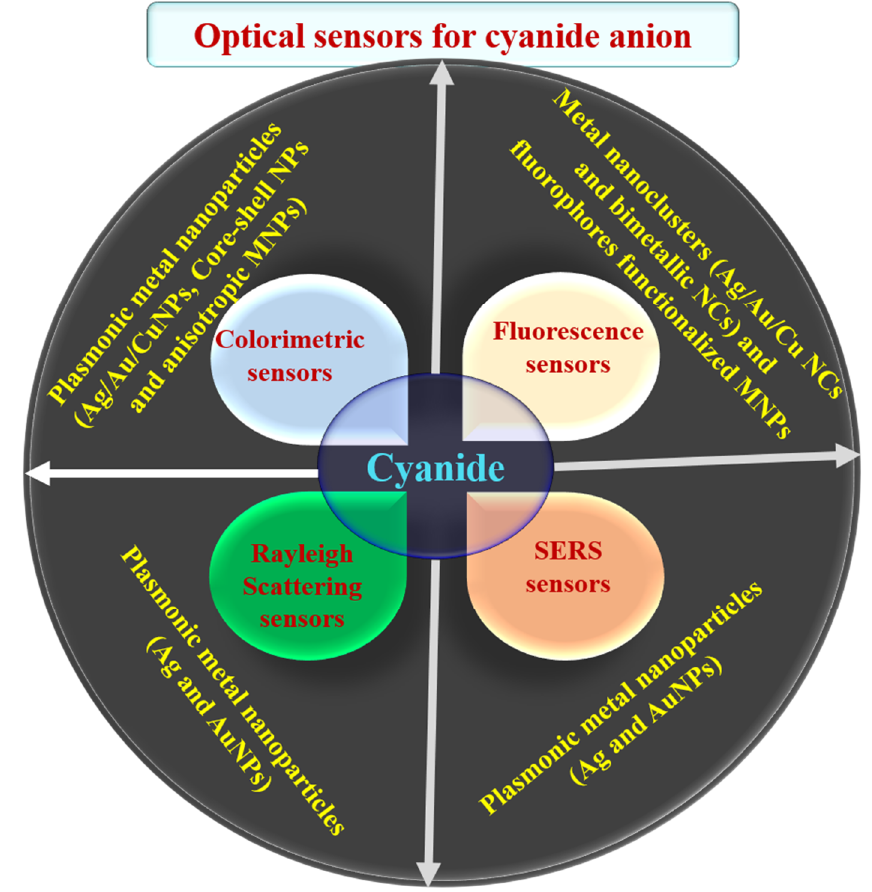
Scheme 1. Schematic representation for the optical chemosensors for cyanide